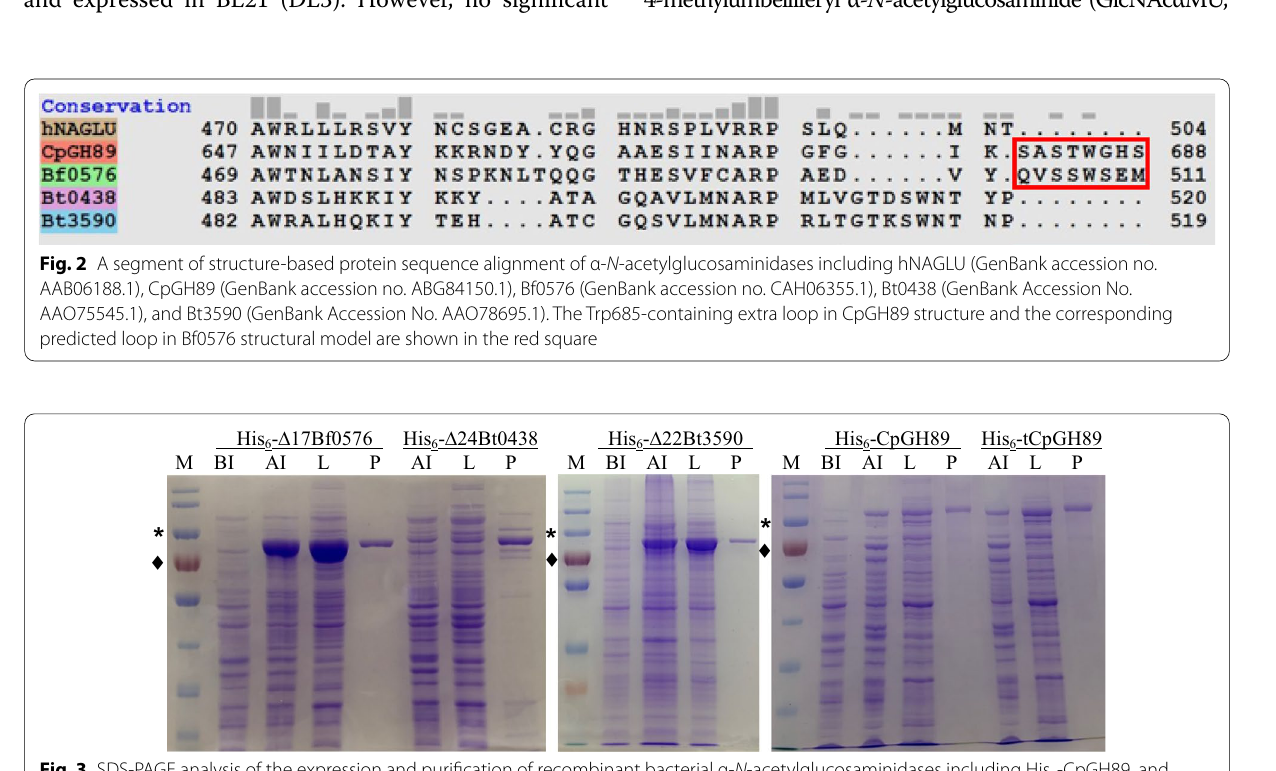
Fig. 3 SDS‑PAGE analysis of the expression and purification of recombinant bacterial α‑ N ‑acetylglucosaminidases including His 6 ‑CpGH89, and loop‑deletion CpGH89 (His 6 ‑tCpGH89), His 6 ‑∆17Bf0576, His 6 ‑∆24Bt0438, His 6 ‑∆22Bt3590. Lanes: M, Thermo Scientific ™ PageRuler ™ Plus Prestained Protein Ladder (10–250 kDa) for His 6 ‑∆22Bt3590 samples and Thermo Scientific ™ PageRuler ™ Prestained Protein Ladder (10–180 kDa) for other samples. The size of the marker with an asterisk on the left is 100 kDa and the size of the marker with a diamond on the left is 75 kDa); BI, whole cell extract before induction; AI, whole cell extract after induction; L, lysate after induction; P, Ni 2 + ‑NTA column purified